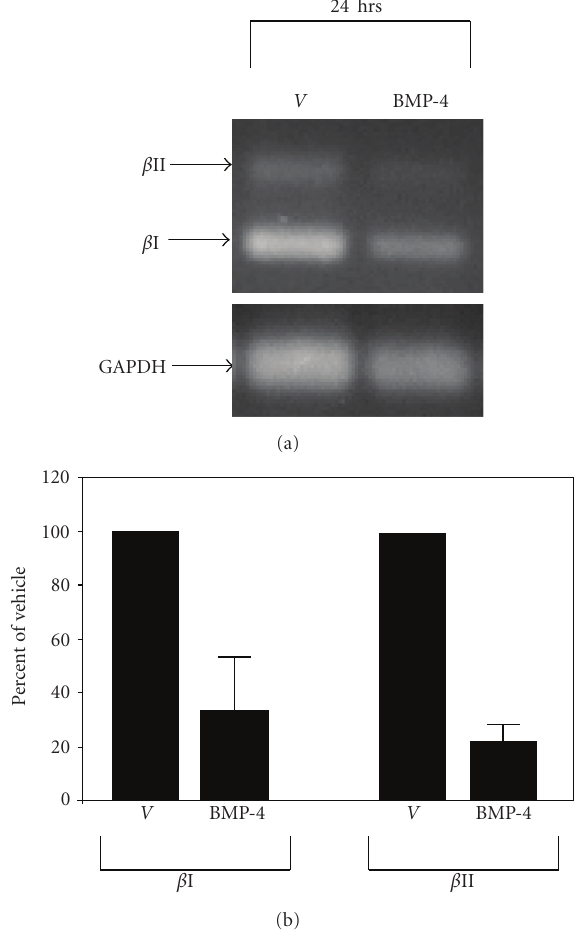
Figure 6: BMP-4 decreases the levels of PKC - β in mRNA in LH melanoma cells . Quantitative Real-Time PCR was performed using the same cDNA used in semi-quantitative RT-PCR (a). The level of PKC- β transcripts were normalized using the level of GAPDH transcripts. Results were then expressed as the percent of the vehicle-treated samples (b). In three independent experiments, BMP-4 significantly decreased the level of PKC- β transcripts ( P < . 03).